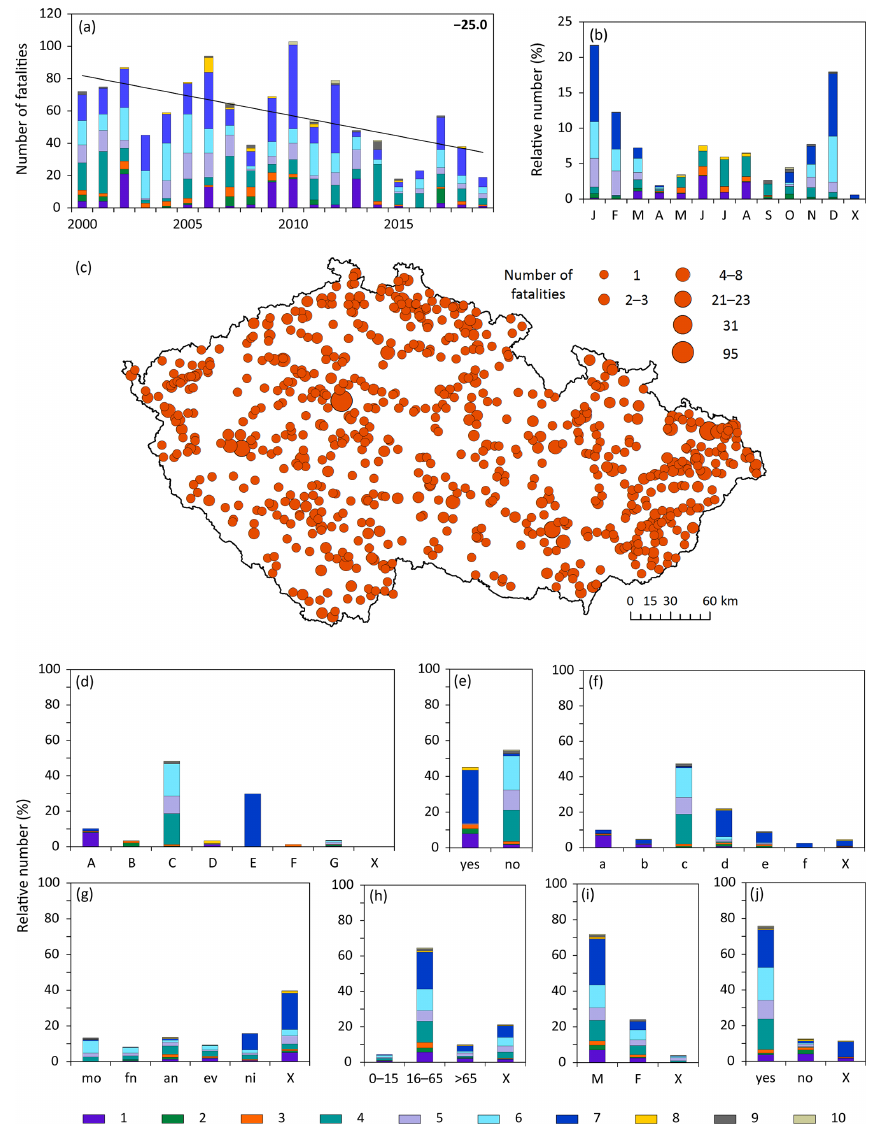
Figure 10. Characteristics of weather-related fatalities (1 – flood, 2 – windstorm, 3 – convective storm, 4 – rain, 5 – snow, 6 – glaze ice, 7 – frost, 8 – heat, 9 – fog, 10 – other) in the Czech Republic during the 2000–2019 period: (a) fluctuation with linear trend (top right, fatalities/10 years), (b) annual variation, (c) spatial distribution (36 fatalities lack exact locations), (d) cause of death, (e) type of fatality, (f) place of death, (g) part of the day, (h) age, (i) sex, (j) behaviour. For explanation of symbols and abbreviations see Fig.